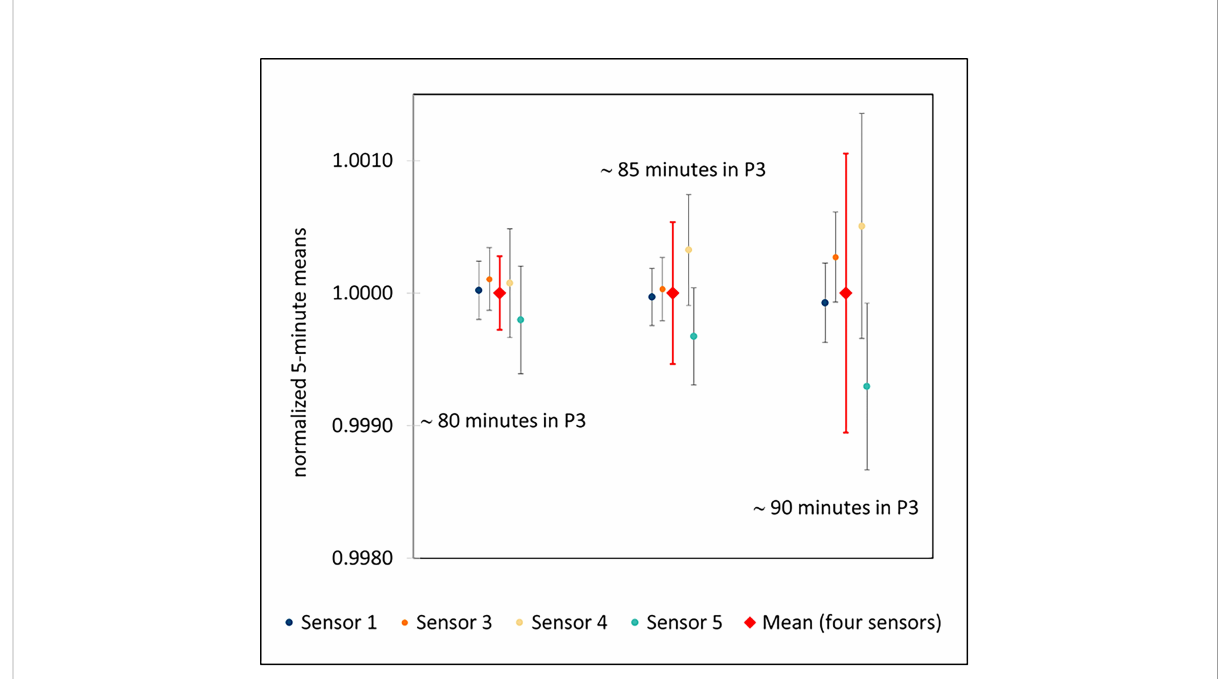
individual group have been measured in the same time interval, however, the values of a group have been slightly shifted along the x-axis to improve visibility of the individual results and their uncertainty bars. The red dot in the middle of each group indicates the average of the four sensor results in that group, simply calculated by the arithmetic mean of the four results. The